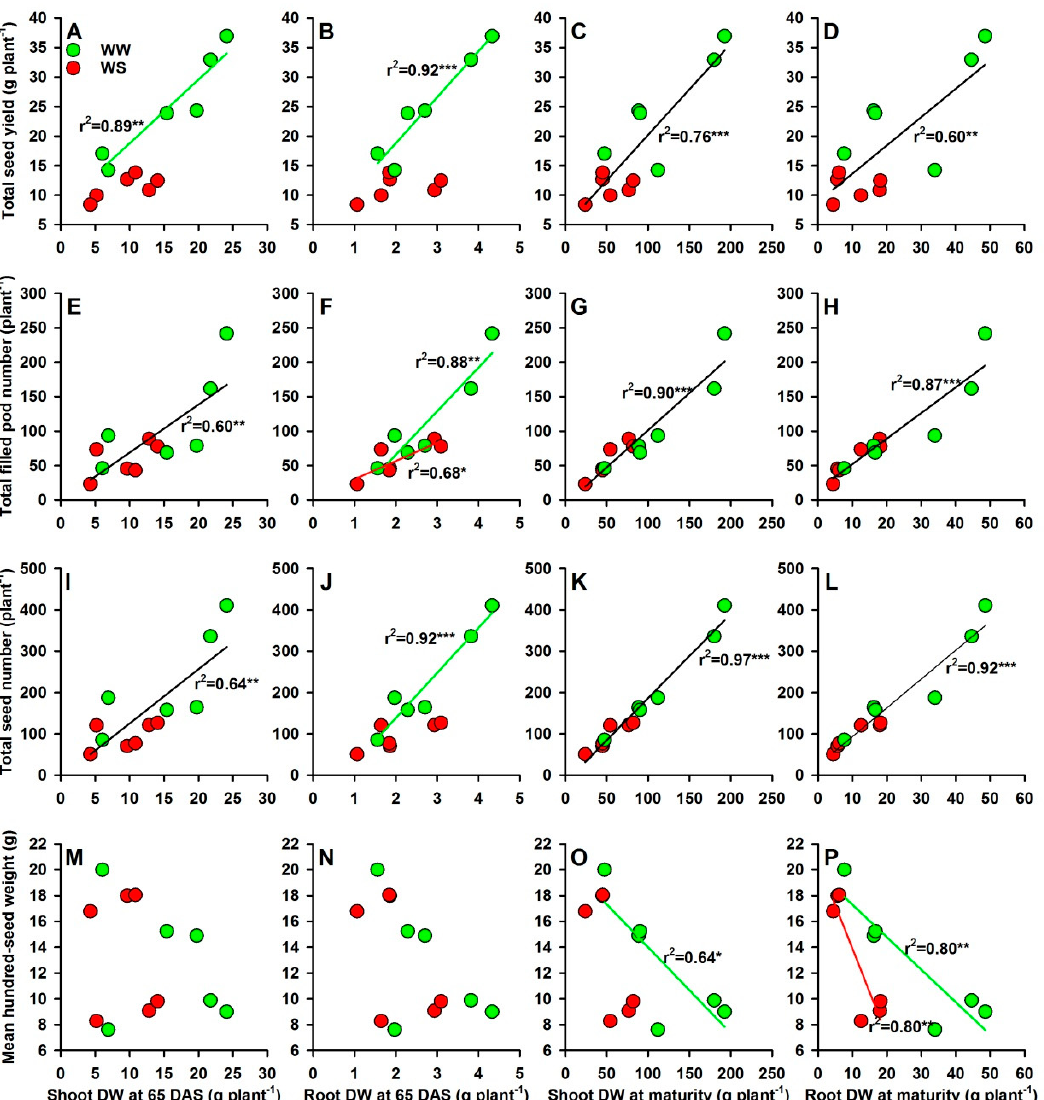
Figure 6. Relationships between total (main stem and branches) seed yield ( A – D ), total filled pod number ( E – H ), total seed number ( I – L ) and mean hundred-seed weight ( M – P ) and shoot dry weight (DW) at 65 days after sowing (DAS) ( A , E , I , M ), root dry weight at 65 DAS ( B , F , J , N ), shoot dry weight at maturity ( C , G , K , O ) and root dry weight at maturity ( D , H , L , P ) in soybean genotypes Huangsedadou and Zhonghuang 30 with three levels of applied P (0 (P0), 60 (P60) and 120 (P120) mg P kg –1 dry soil) and two water treatments (well-watered (WW, green circles) and cyclic water stress (WS, red circles)). The lines (green, WW; red, WS; black, combined WW and WS when the individual regressions did not differ significantly) give the fitted linear regressions; the correlation coefficients ( r 2 ) are given; * p < 0.05, ** p < 0.01, *** p < 0.001.